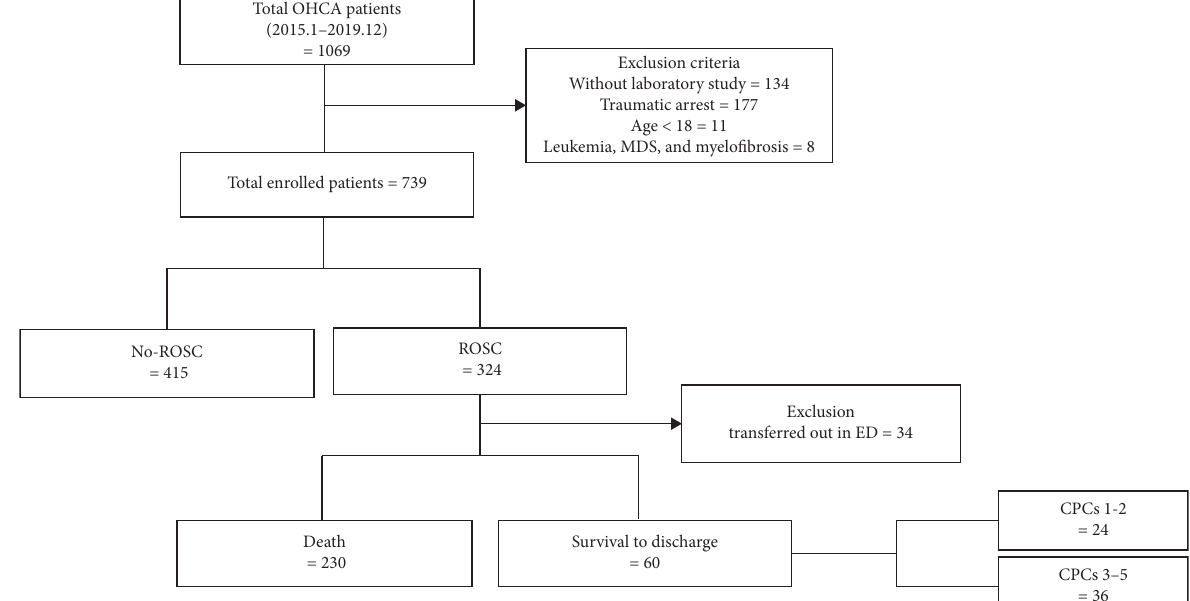
Figure 1: Enrollment